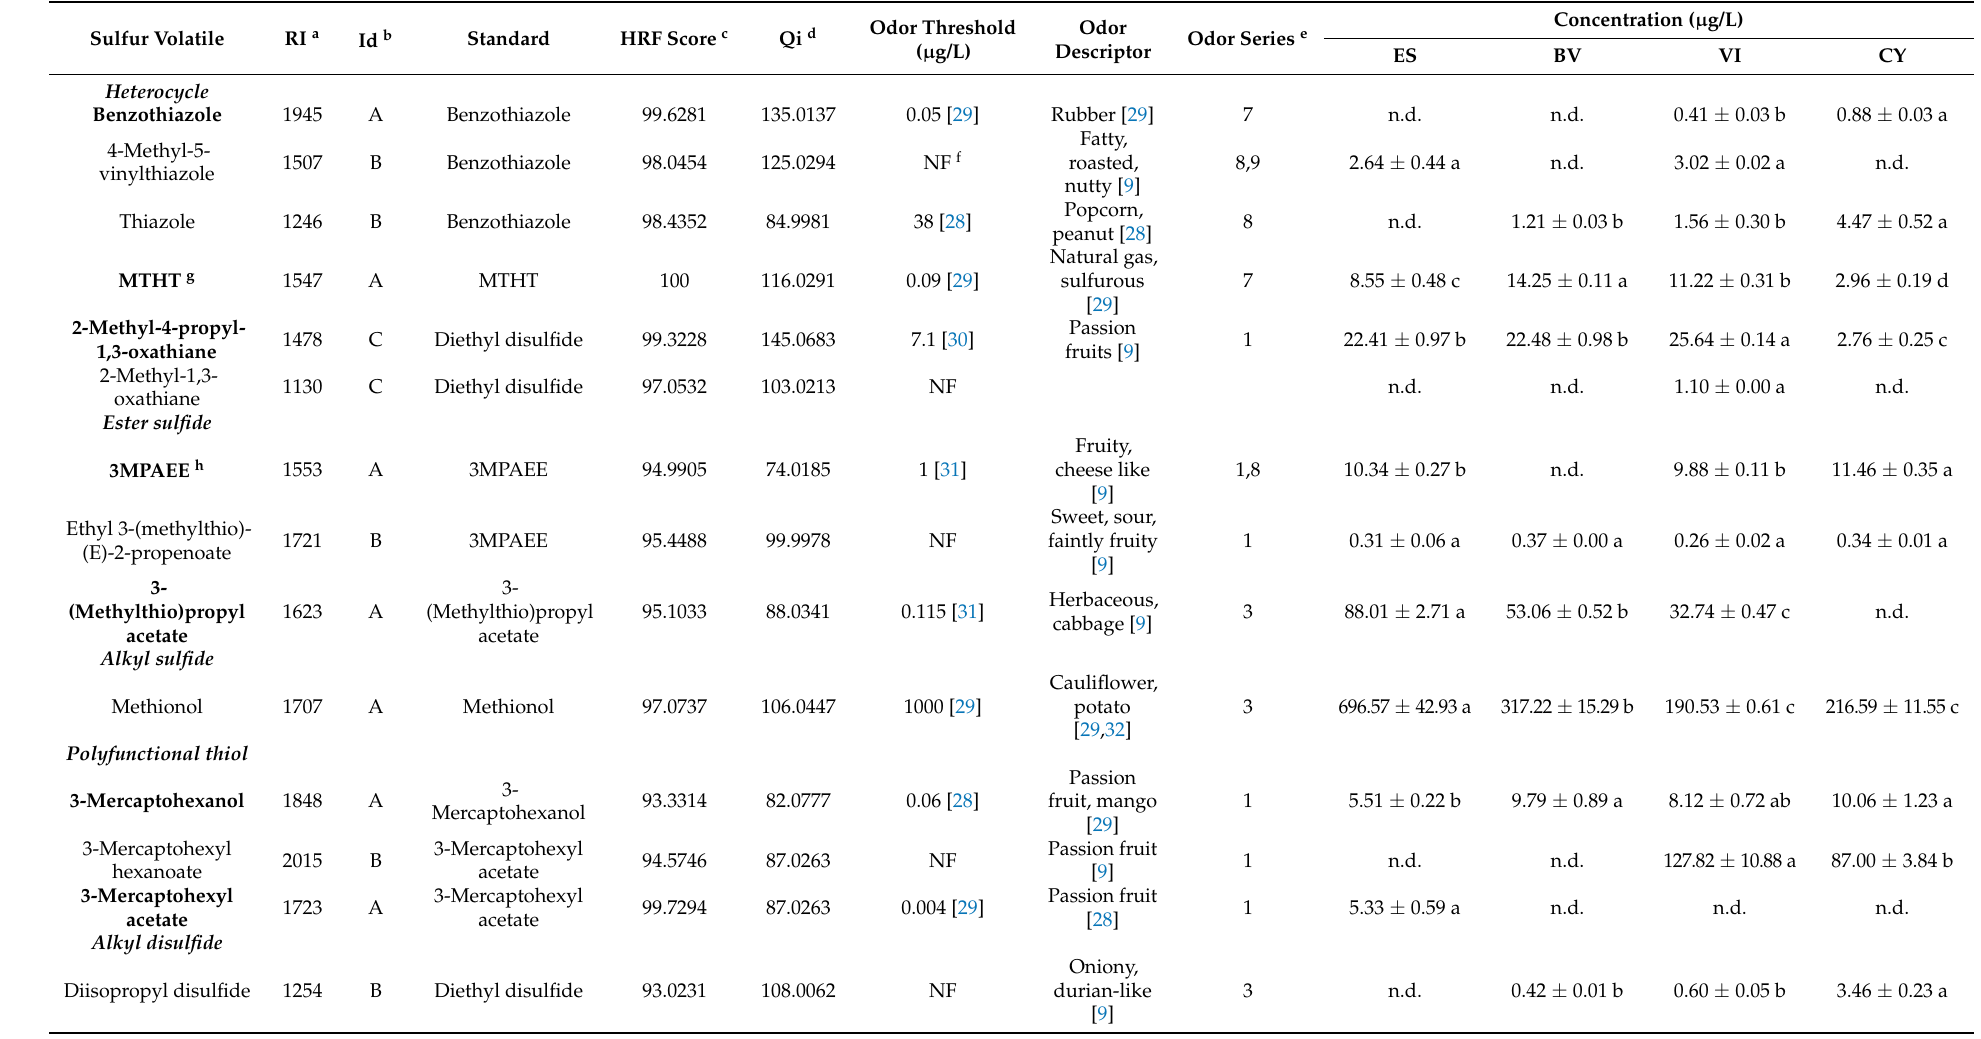
Table 2. Sulfur volatile compounds in passion fruit wine fermented by commercial yeast strain ES488 (ES), BV818 (BV), VIC (VI) and CY3079